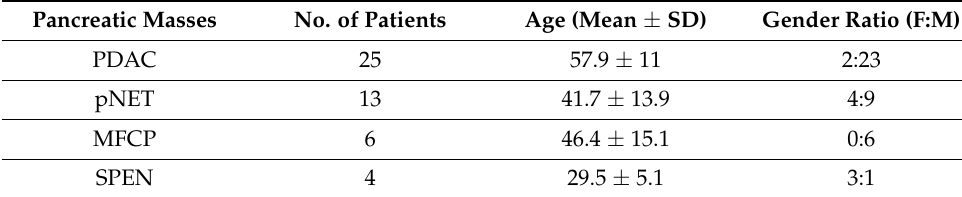
Table 2. Clinical demographics of patients with pancreatic masses. Pancreatic